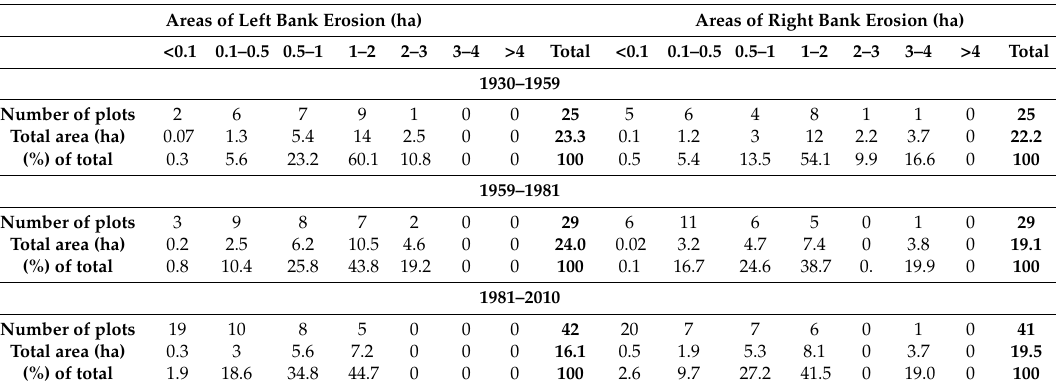
Table 2. Distribution of the bank erosion. Areas of Left Bank Erosion (ha) Areas of Right Bank Erosion (ha)